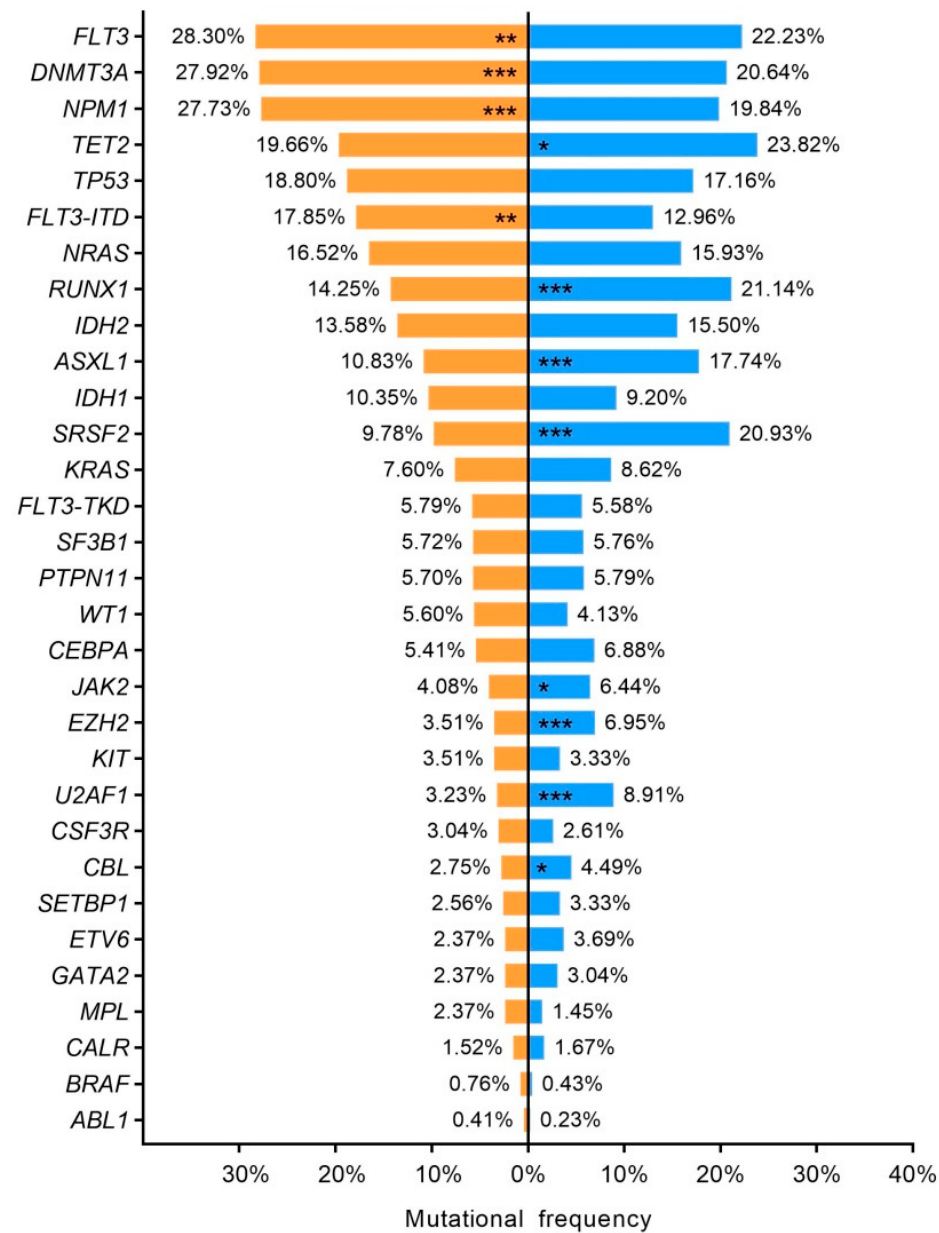
Figure 5. Sex–related mutational profile. Bar chart representing mutational frequencies. Orange; female, blue; male. * p < 0.05, ** p < 0.01, *** p < 0.001. ITD: internal tandem duplication; TKD: tyrosine kinase domain.